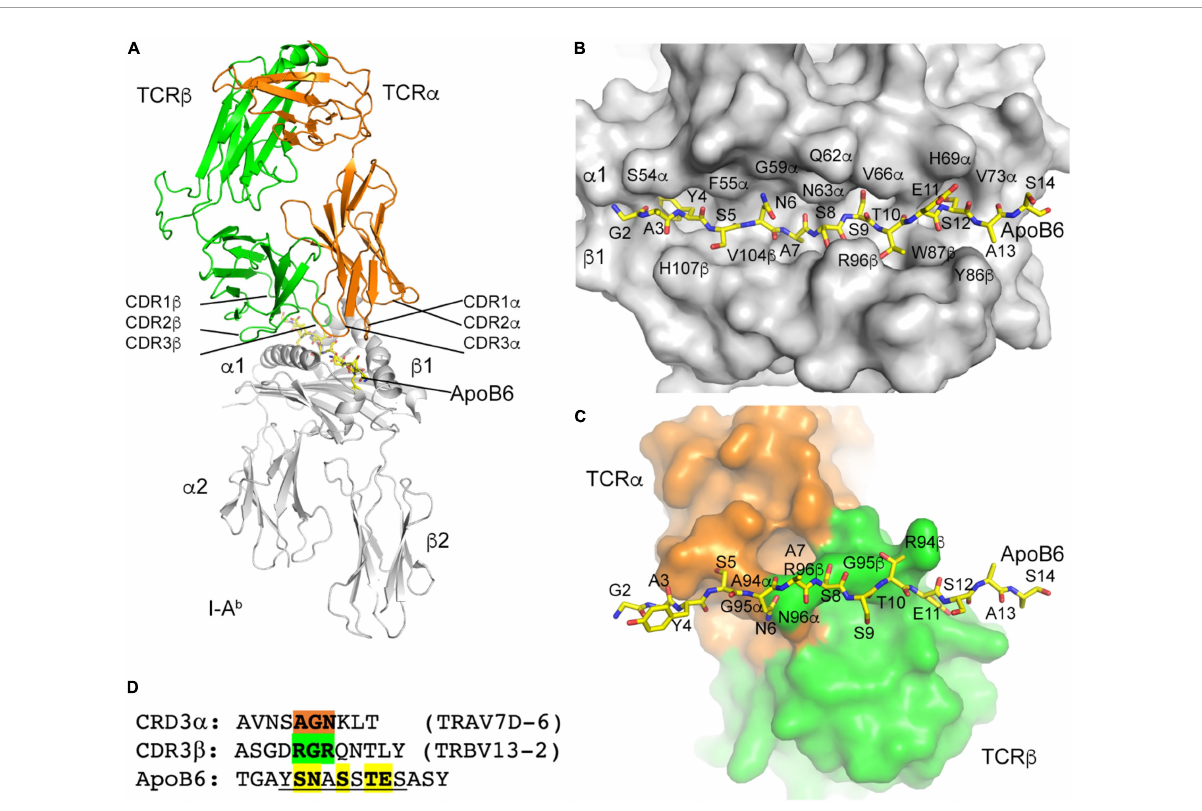
FIGURE5 I-A b ApoB P6 peptide and TCR modeling. (A) Overview of the TCR/I-A b /ApoB P6 complex with I-A b in gray, TCR α in orange and TCR β in green. ApoB P6 peptide in yellow sticks. (B) Binding of the ApoB P6 peptide in the I-A b binding groove identifies amino acid residues that are accessible for TCR binding. (C) TCR-ApoB P6 contact residues. (D) TCR α contact residues highlighted orange and TCR β residues green. The ApoB P6 core peptide is underlined and contact residues are highlighted